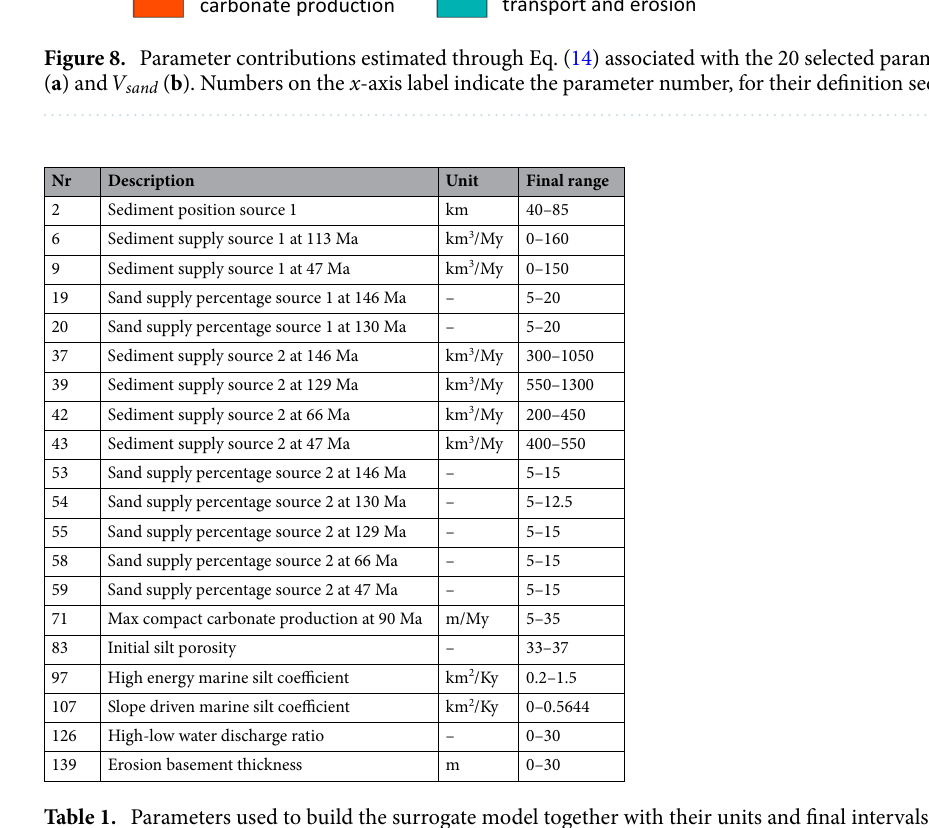
Figure 9 depicts the marginal probability distributions of p i obtained from 500 calibrations. We can subdivide the parameters according to three groups according to the results: • Identifiable parameters: this subset includes parameters whose marginal distributions are fully contained within the investigated ranges and display a single clear peak (such as parameters #2, 6, 37, 39, 42, 71, 97, 107, 126). For these parameters the procedure provides well identified best estimates and an approximation of their uncertainty. Estimates of parameters 6 and 107 are close to the interval boundaries, however they